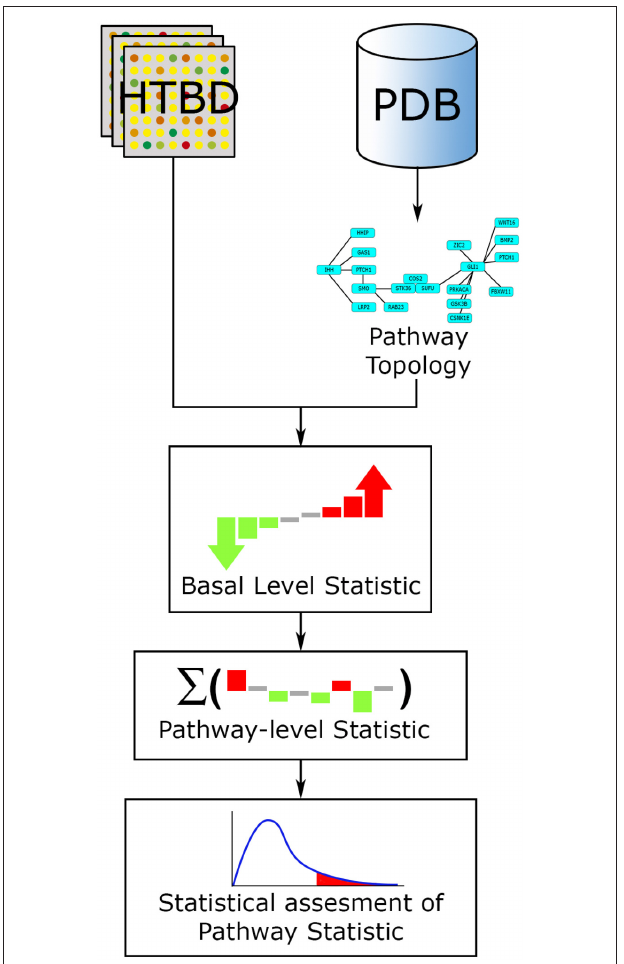
FIGURE 6 | PTB analysis general workflow. The main inputs for PTB methods are the HTBD and the pathways extracted from PDBs, in pathway topology format. All HTBD and pathway topology is used to calculate the basal-level statistics. After this, the basal-level statistics of the components of each pathway is aggregated into a pathway-level statistic. Finally statistical assessment of the pathway-level statistics is